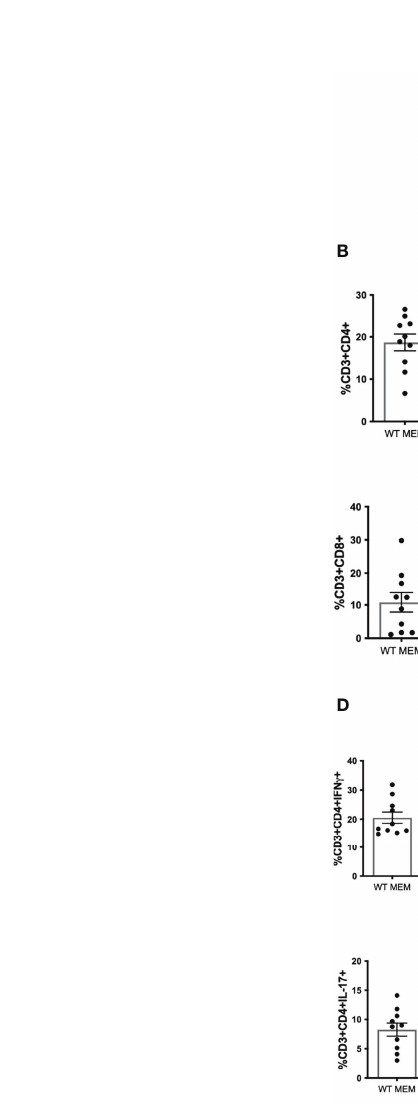
FIGURE 5 | Memory B cells from IFNARko/WT mice infected with g HV-68 or not, were transferred to uninfected WT mice. 24 hours after the transfer, EAE was induced. At days 16-18 post EAE induction, mice were perfused; brains and spinal cords were harvested and processed to isolate immune in fi ltrates. (A) EAE scores up to day 18 post induction. (B) CD4 + and CD8 + in fi ltrating cells in the brain and (C) spinal cord. (D) Percentage of CD4 + IFNg + and CD4 + IL-17 + in the brain and (E) spinal cord. Four independent experiments with 11-20 mice/group. Data analyzed with Student ’ s t-test: